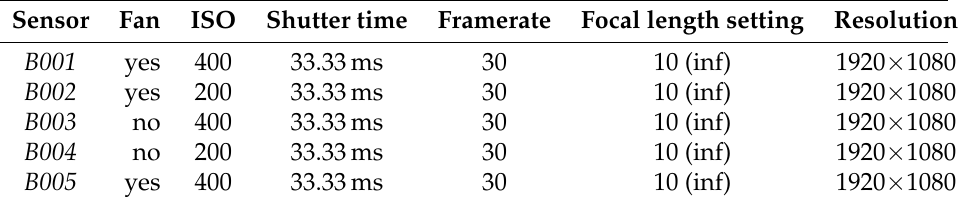
Table 1. Device configuration in CDPC